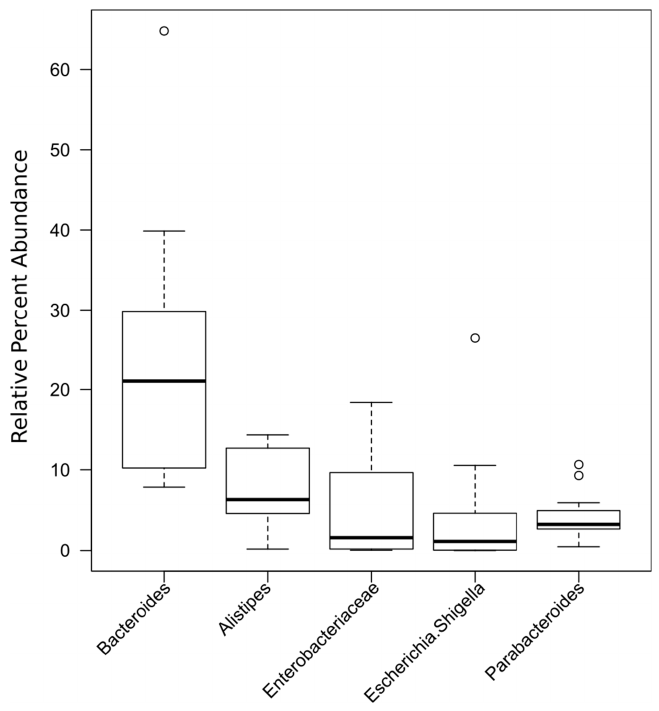
Figure 5. Boxplot of most abundant taxa from all the samples.